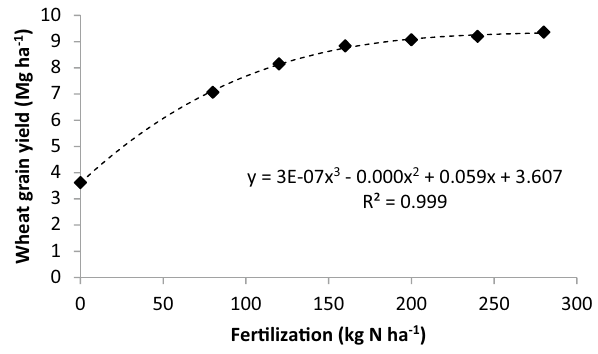
Fig. 1 Yield of winter wheat (Mg ha −1 ) as a function of nitrogen fer- tilization rate (kg ha −1 ). Based on data from 10 years of field trials in southern Sweden. Compiled by Borling and used by the Swedish Board of Agriculture in recommendations to farmers [36]